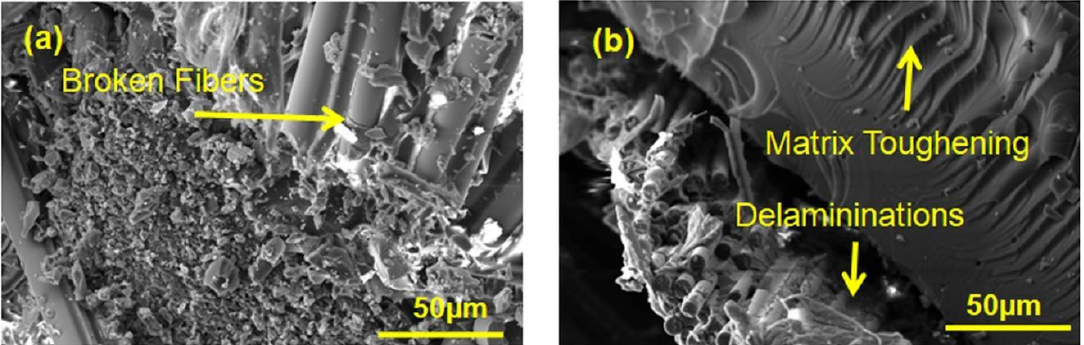
Figure 9. SEM images of the fractured surface of the hybrid composites D ( a ) fiber broken ( b ) matrix toughening and delamination.